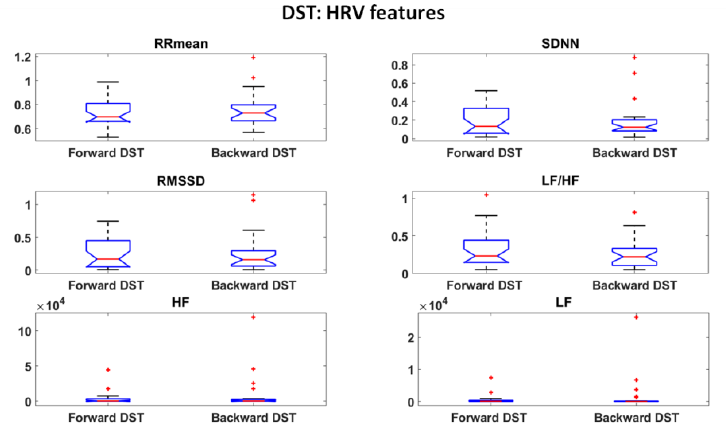
Figure 8. HRV features extracted during DST. Outliers are represented with red crosses. The titles of the single plots refer to abbreviations of features described in Section 3.3.